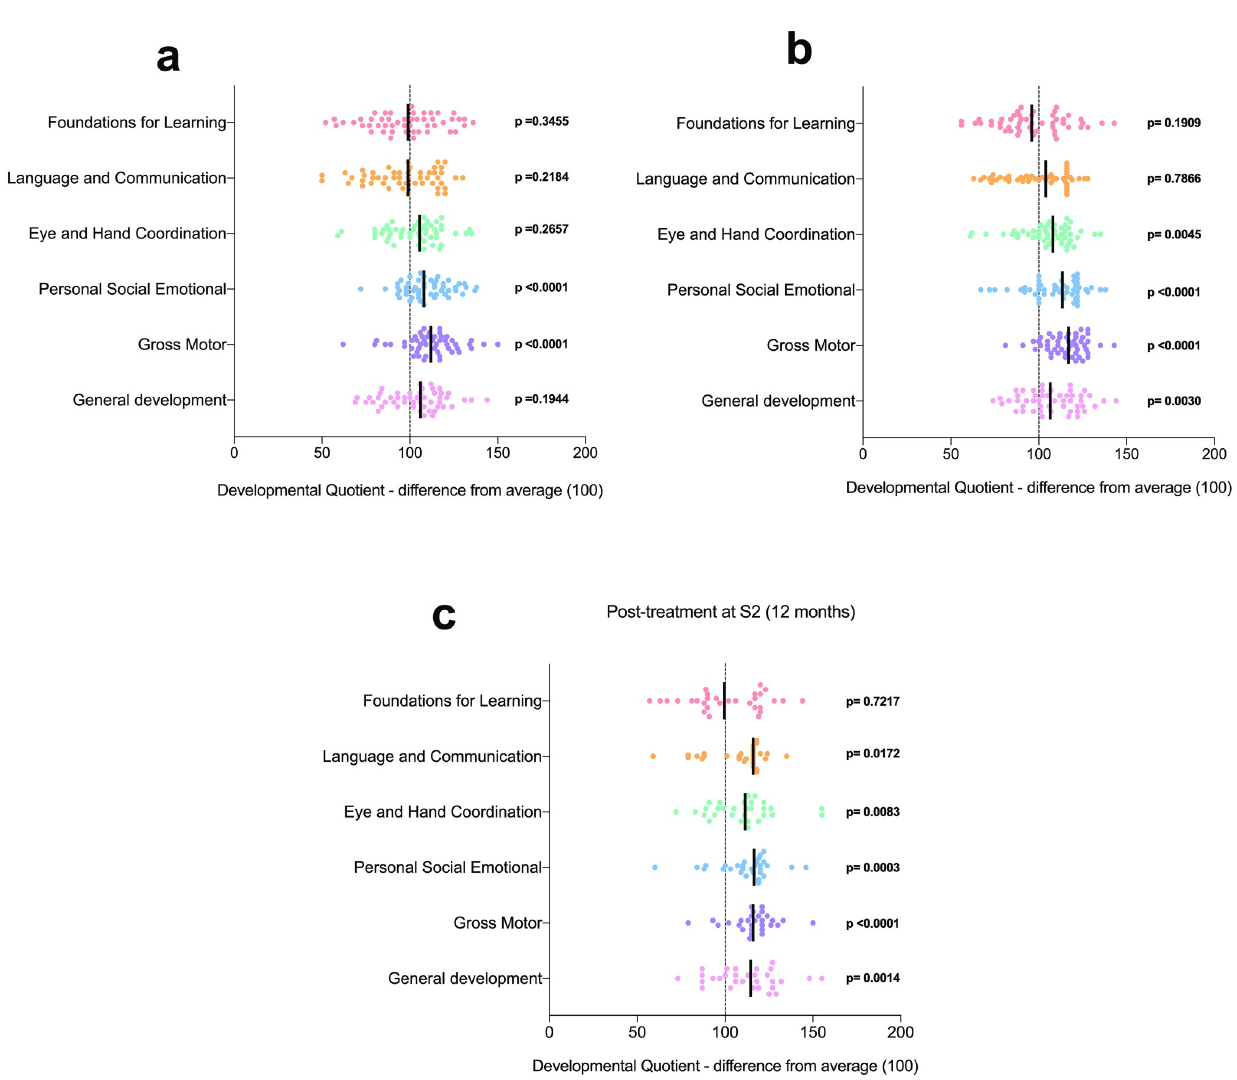
Fig 5. Six- and 12-month time course of developmental quotient (DQ) scores for untreated/uninfected children. Scatterplots show DQ scores for a) children negative for S . haematobium infection at baseline (n = 50), b) children present at S1 survey (6 months later) and remained negative for S . haematobium infection (n = 50), and c) children present at S2 survey (12 months later) who remained negative for S . haematobium infection (n = 29). Dotted lines represent the mean reference average for DQ (100). p-values indicate statistical tests for either a one sample t-test or Wilcoxon sign test (based on normality) comparing to the hypothetical mean of 100. Solid lines =